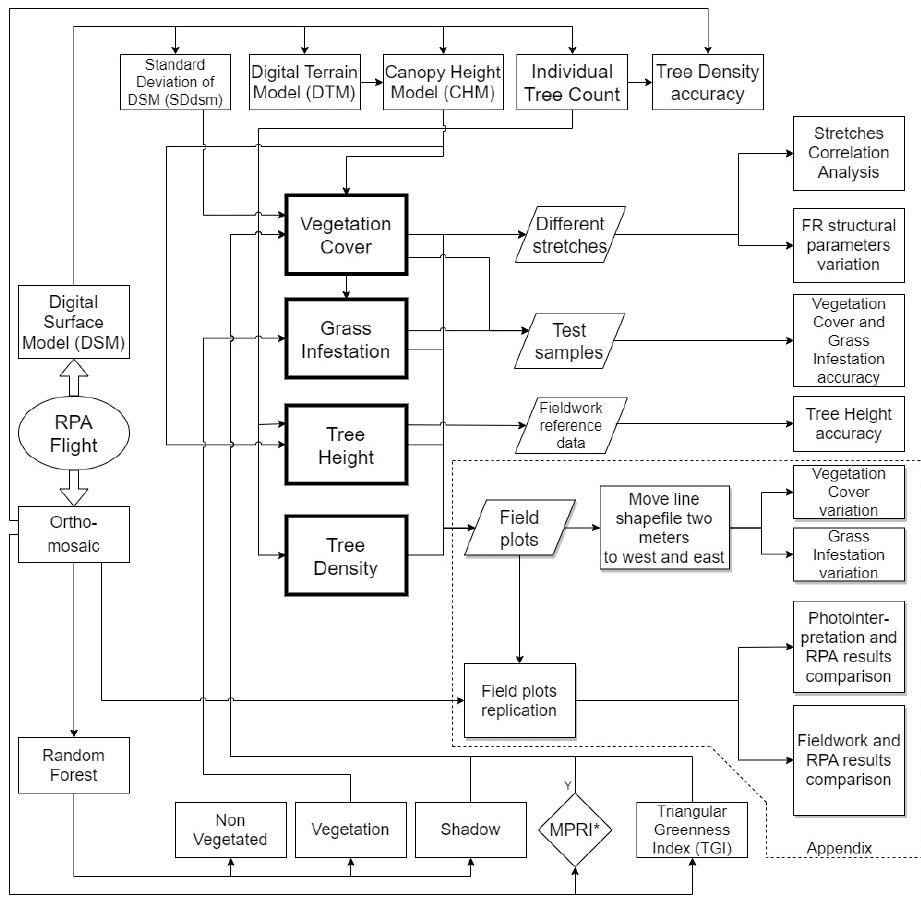
Figure 2. Methodology workflow of this study. MPRI is the Modified Photochemical Reflectance Index [23] and should be used only in the absence of